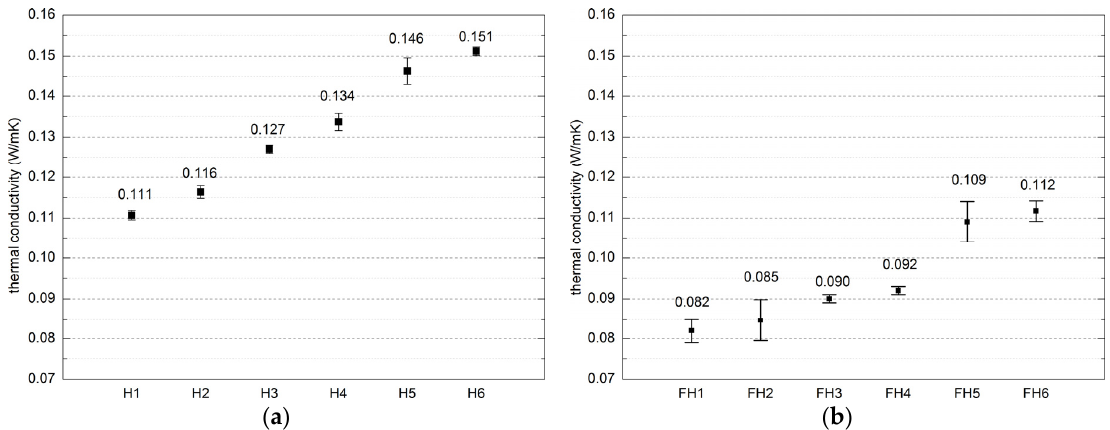
Figure 11. Thermal conductivity coefficient of composites (error bars mean standard deviation of heat conductivity coefficient): ( a ) Series 1, ( b ) Series 2.